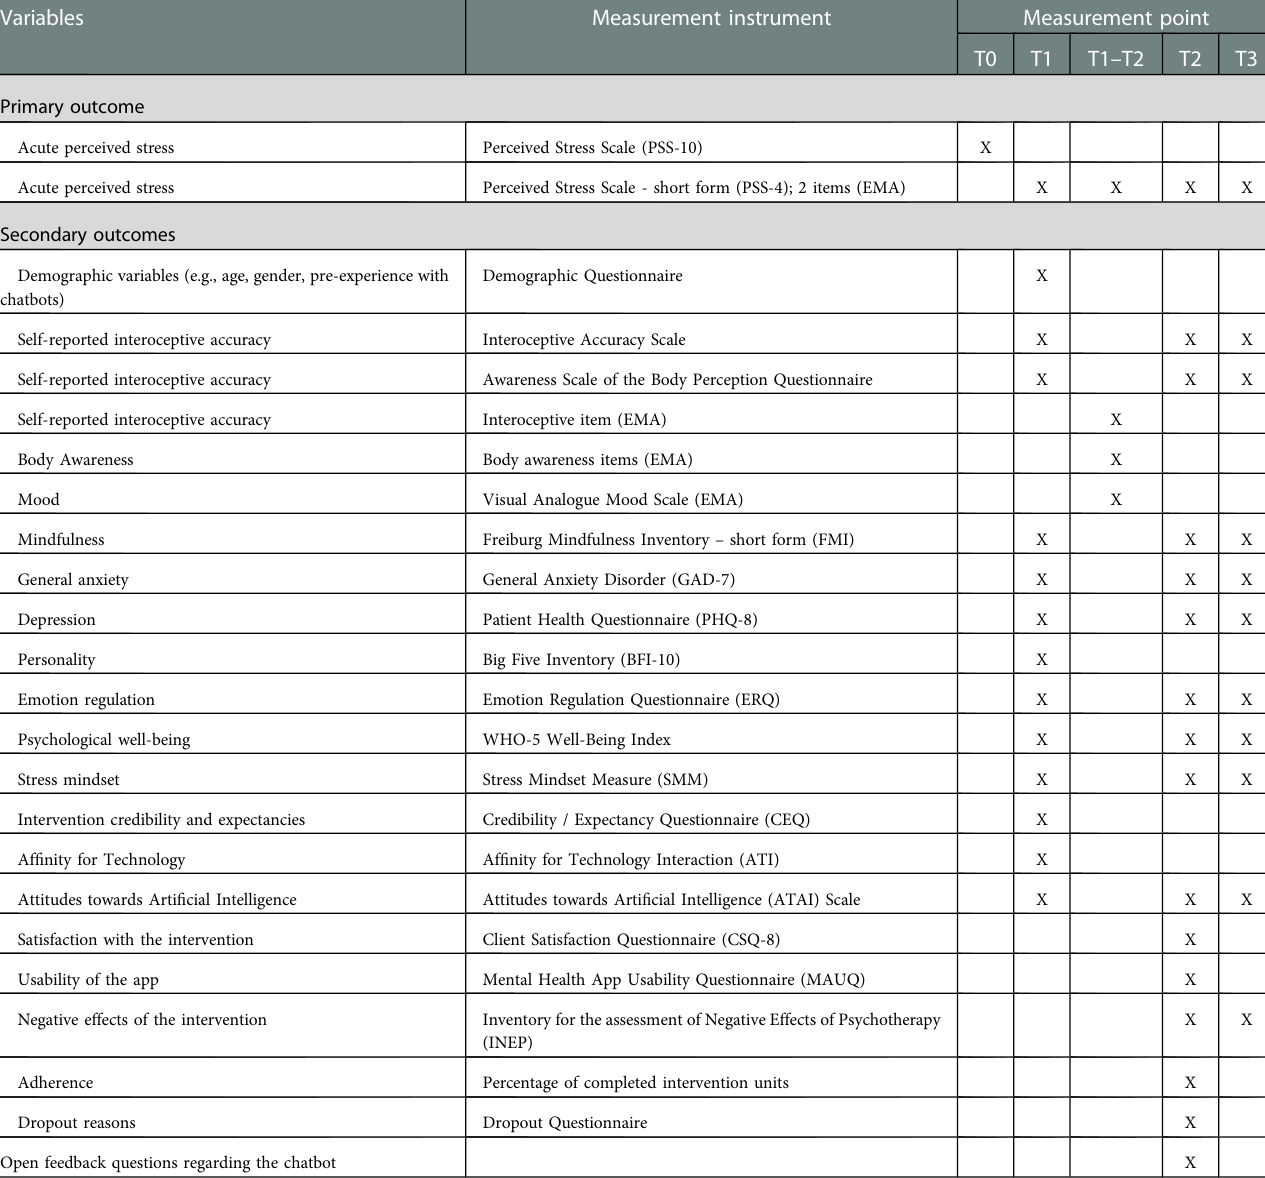
TABLE 2 Assessed variables, measurement instruments and measurement